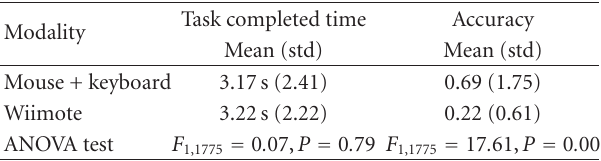
Table 5: Impact of the interaction modality on the task completion time and its accuracy.